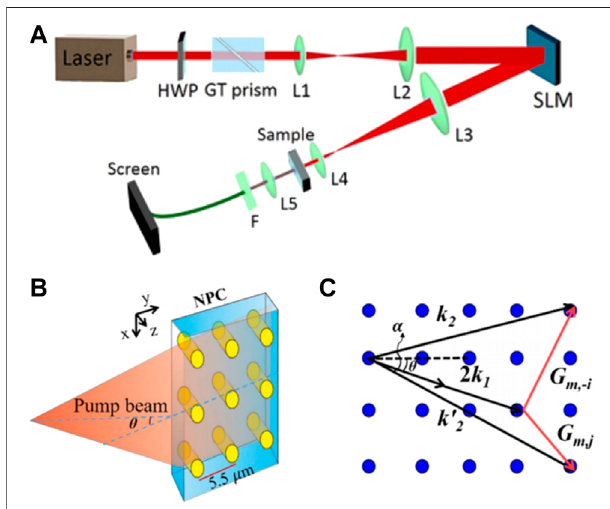
FIGURE 8 | (A) Experimental setup for the nonlinear generation of Airy vortex beam. The sample is a homogenous 5-mol% MgO:LiNbO 3 crystal for second-harmonic generation [94]. (B) Illustration of nonlinear non-diffracting array beam generation [95]. (C) Non-collinear quasi-phase-matching diagram [95]. Reproduced with permission from OSA [94,